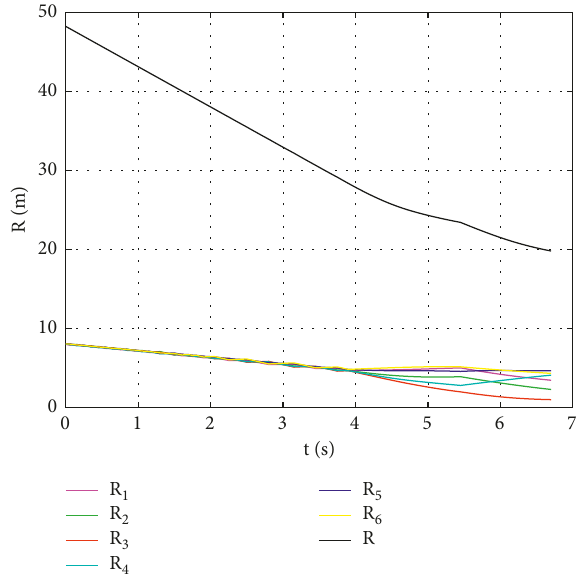
Figure 4: The changes in the distance between pursuers and evader ( N � 6, λ � 0 .